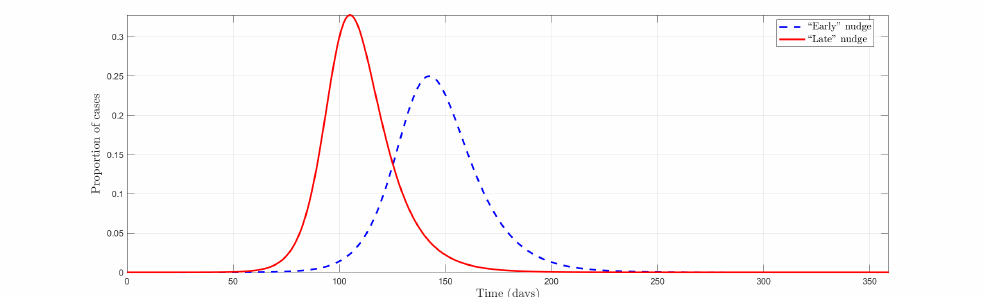
Figure A6. Timing effect in a nudge on protection